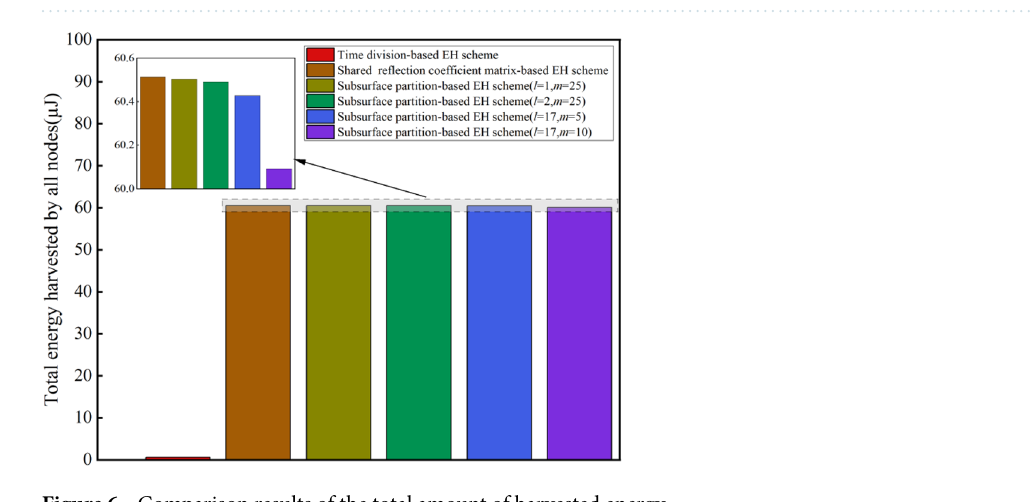
Figure 6. Comparison results of the total amount of harvested